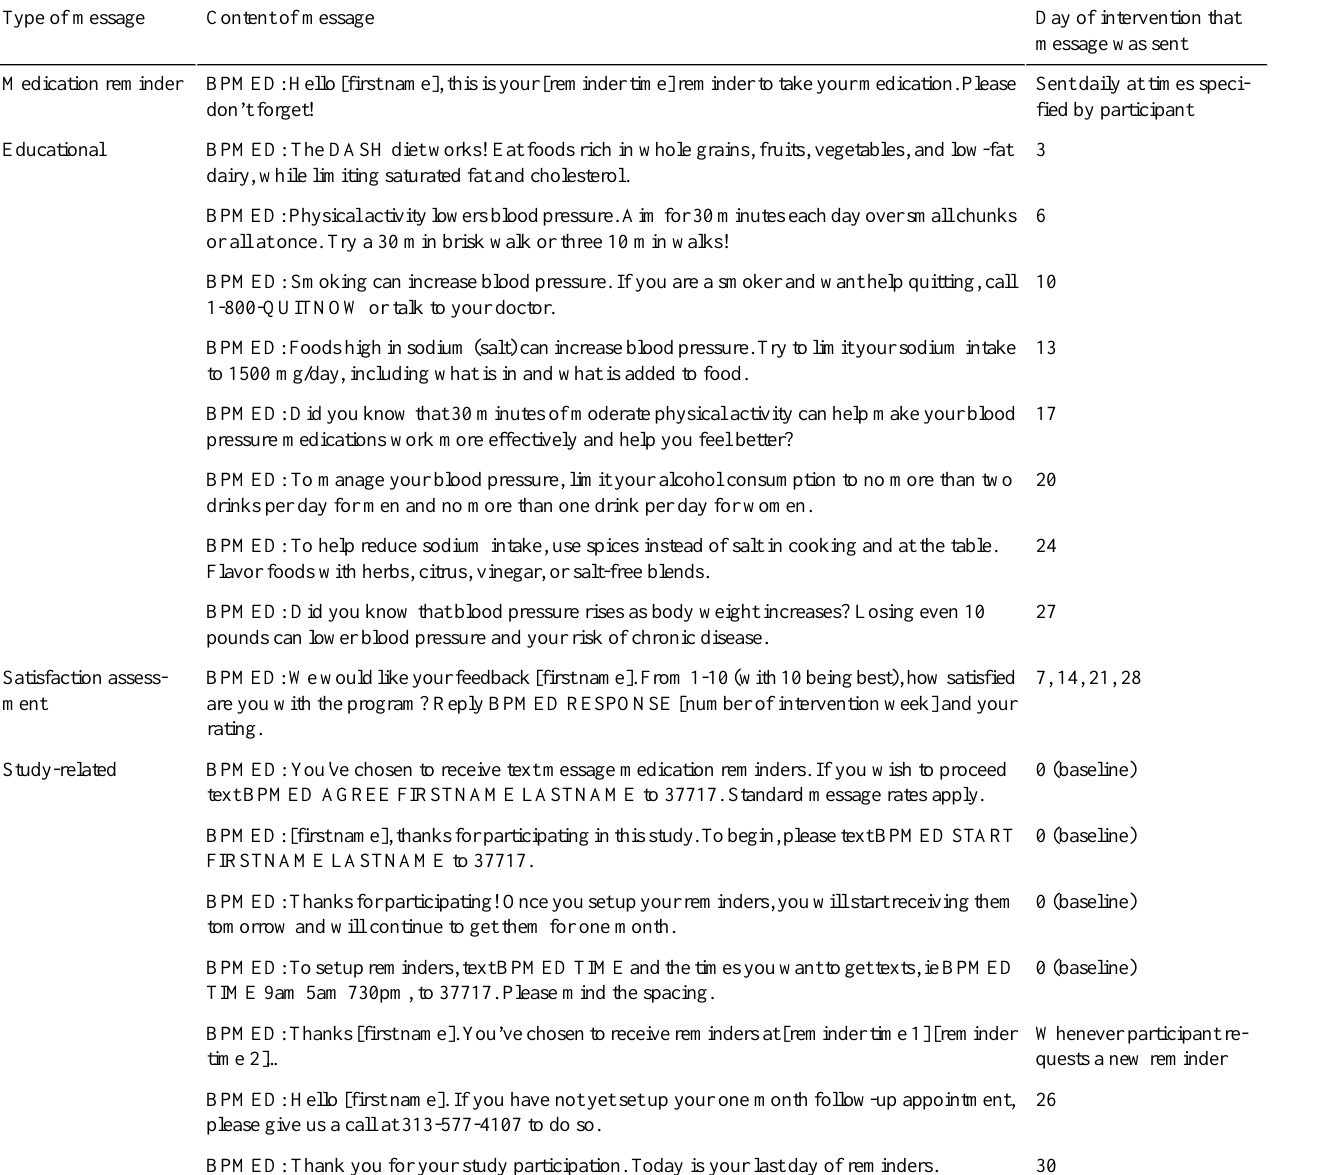
Table 2. Text messages included in BPMED by type.